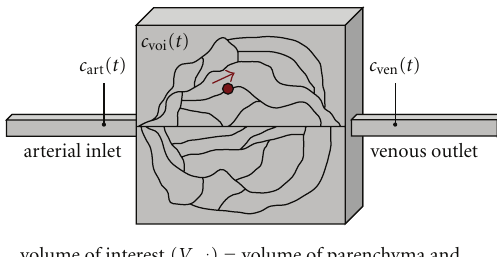
Figure 2: Physiological model of the tissue perfusion. A blood cell can take several paths through the capillary bed. The variables are defined in Table